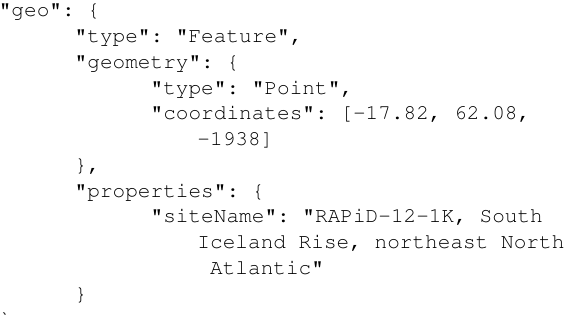
LiPD encodes these data and metadata into a structured hierarchy that allows explicit description of any aspect of the data set at any level of the data (Fig. 1). LiPD serializes this hierarchy using JSON-LD, using nests of lists and key-value pairs. LiPD adopts the GeoJSON standard 2 to describe the